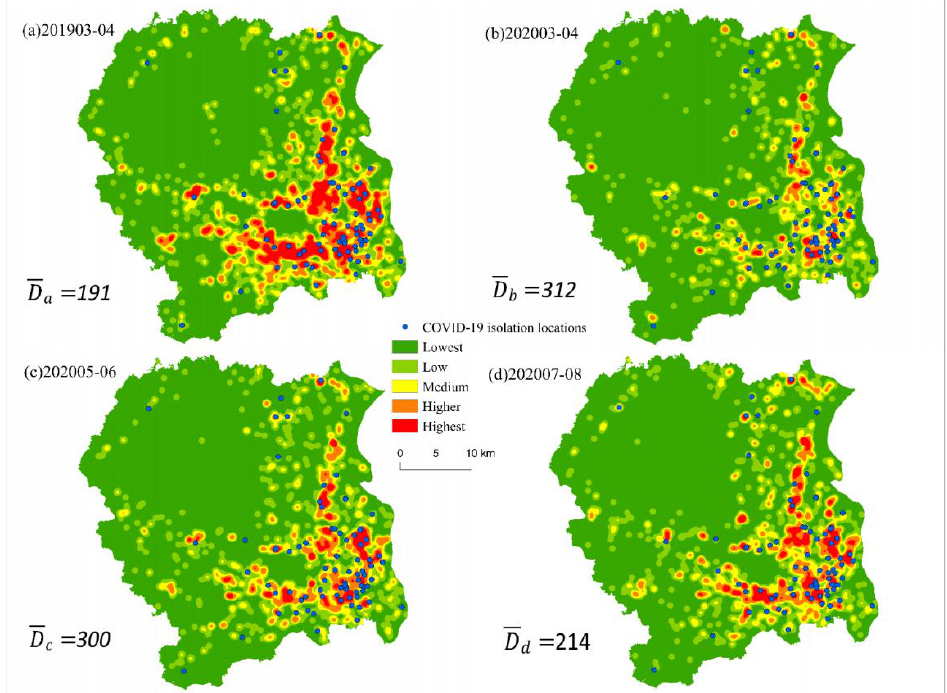
Figure 3. Kernel densities of violent crime during the four time periods: ( a ) pre-COVID-19 pandemic period: March – April 2019; ( b ) Lockdown period: March – April 2020; ( c ) Early post-lockdown period: May – June 2020; ( d ) Late post-lockdown period: June – August 2020. Blue dots indicate isolation locations. The average nearest crime distances are displayed for all four periods.